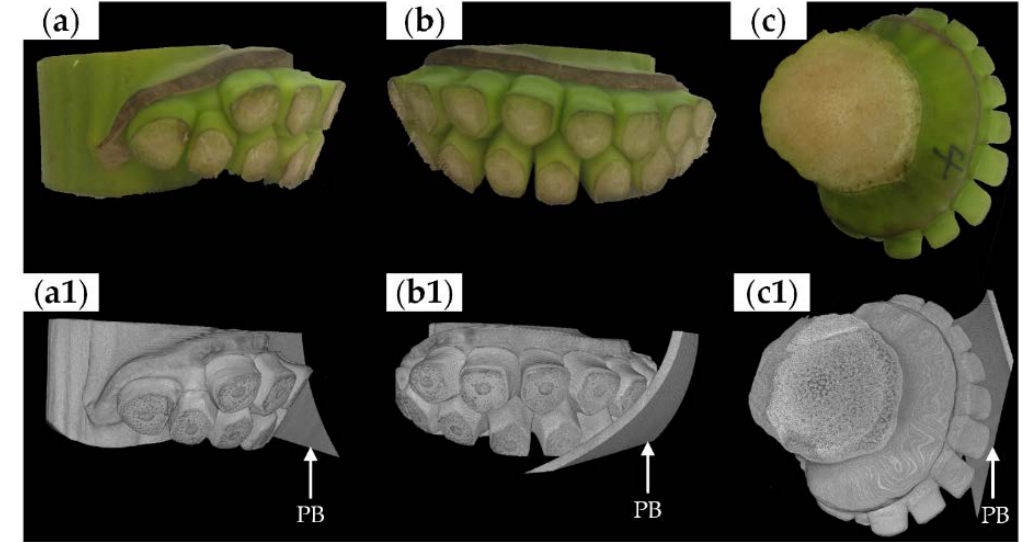
Figure 2. Sample and X-ray Computed Tomography (CT) scanning images of banana crown. ( a ) Side view of the crown; ( b ) front view of the crown; ( c ) top view of the crown; ( a1 ) side view CT scan; ( b1 ) front view CT scan; ( c1 ) top view CT scan. PB = Plastic box.